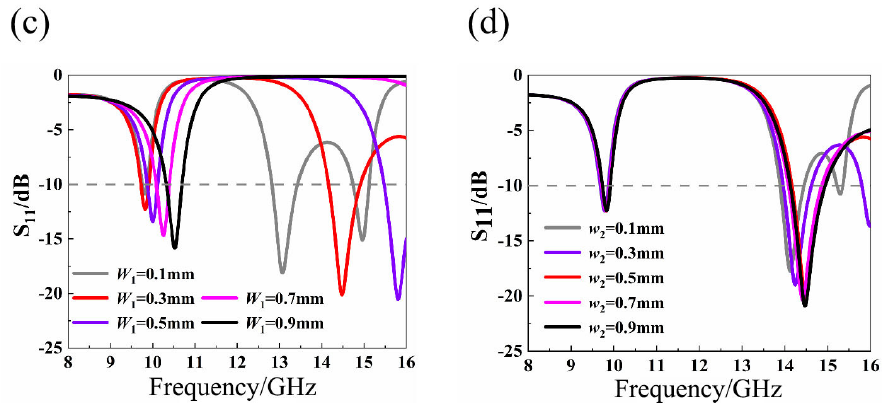
Figure 5. S-parameter curves corresponding to different structural parameter values ( a ) When a 1 is a different value ( b ) When d is a different value ( c ) When w 1 is a different value ( d ) When w 2 is a different value.